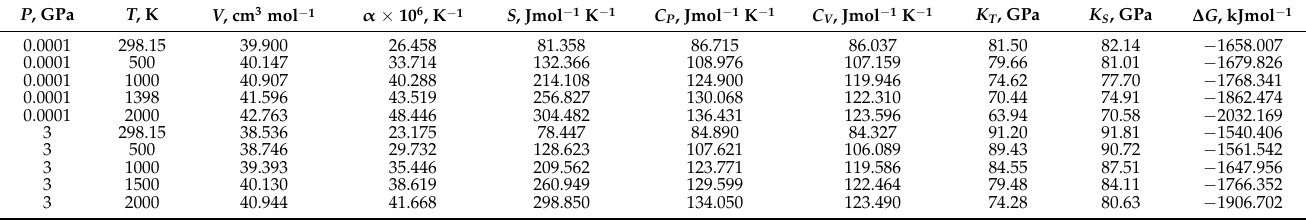
Table 2. Thermodynamic functions of wollastonite at different pressures and